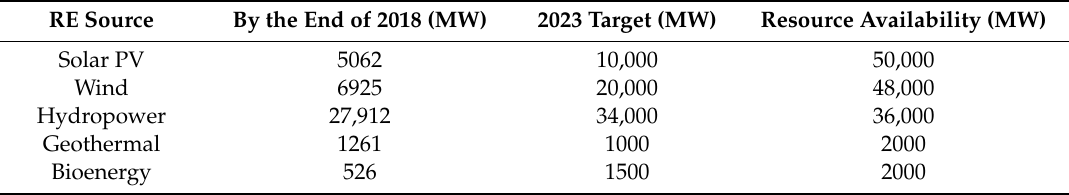
Table 3. Turkey’s RE sources installed capacity, future target, and resource availability [46].